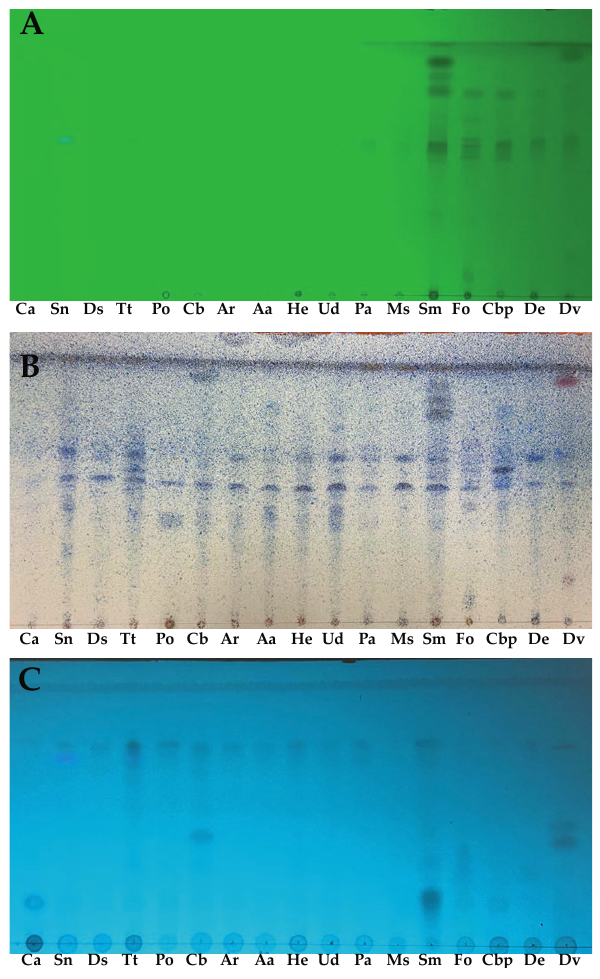
Figure 4. TLC analyses of plant root extracts from: Ca, Convolvu- lus arvensis L.; Sn, Solanum nigrum L.; Ds, Datura stramonium L.; Tt, Tribulus terrestris Boiss.; Po, Portulaca oleracea L.; Cb, Conyza bonariensis L.; Ar, Amaranthus retroflexus L.; Aa, Amaranthus albus L.; He, Heliotropium europaeum L.; Ud, Urtica dioica L.; Pa, Polygo- num aviculare L.; Ms, Malva sylvestris L.; Sm, Silybum marianum (L.) Gaertn.; Fo, Fumaria officinalis L.; Capsella bursa-pastoris (L.) Medik.; De, D. erucoides (L.) DC. and Dv, D. virgate (Cav.) DC.. A, Chromatograms obtained using silica gel plates eluted with CHCl 3 - iso -PrOH 9:1 v/v and spots visualized by exposure to UV light (254 nm); B, Chromatograms obtained using silica gel plates eluted with CHCl 3 - iso -PrOH 9:1 v/v and visualized by spraying first with 10% H 2 SO 4 in MeOH, and then with 5% phosphomolybdic acid in EtOH, followed by heating at 110°C for 10 min; C, Chromatogram obtained using reverse phase plates eluted with MeCN-H 2 O 6:4 v/v and spots visualized by exposure to UV light (254